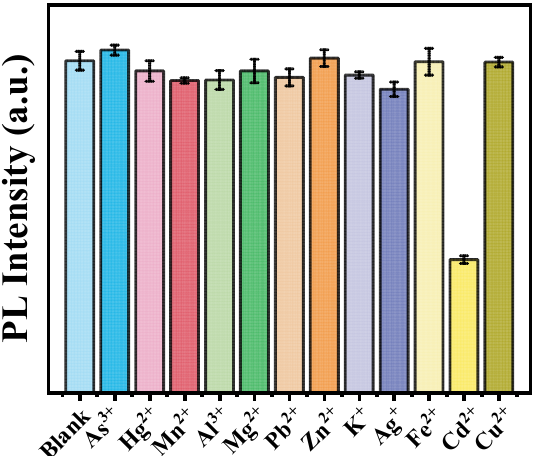
Figure 6 . The selectivity of the aptasensor for Cd 2+ against As 3+ , Hg 2+ , Mn 2+ , Al 3+ , Mg 2+ , Pb 2+ , Zn 2+ , K + , Ag + , Fe 2+ , and Cu 2+ .